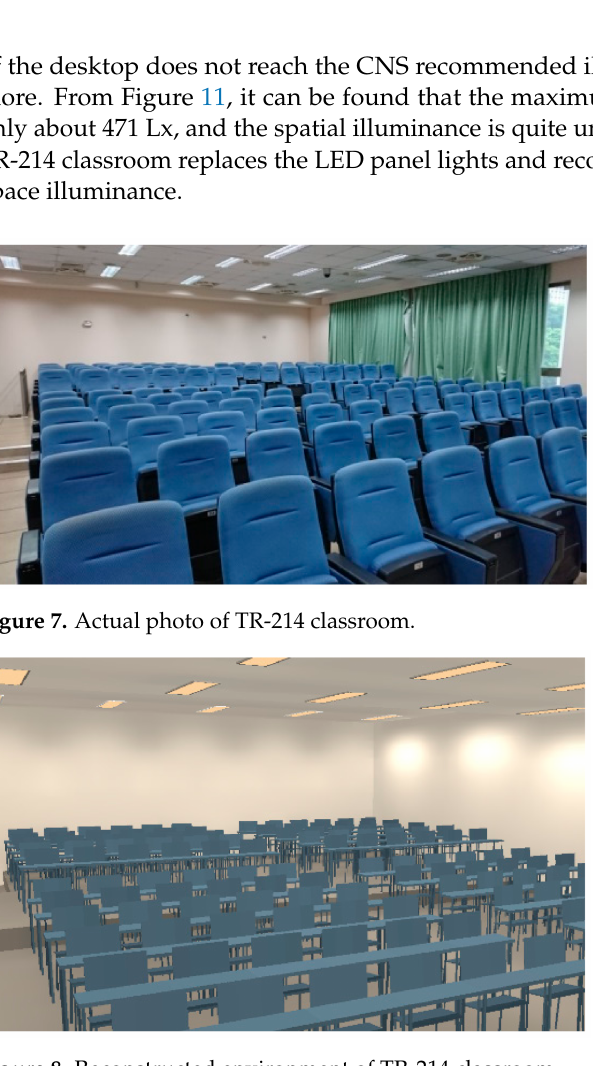
Figure 8. Reconstructed environment of TR-214 classroom.